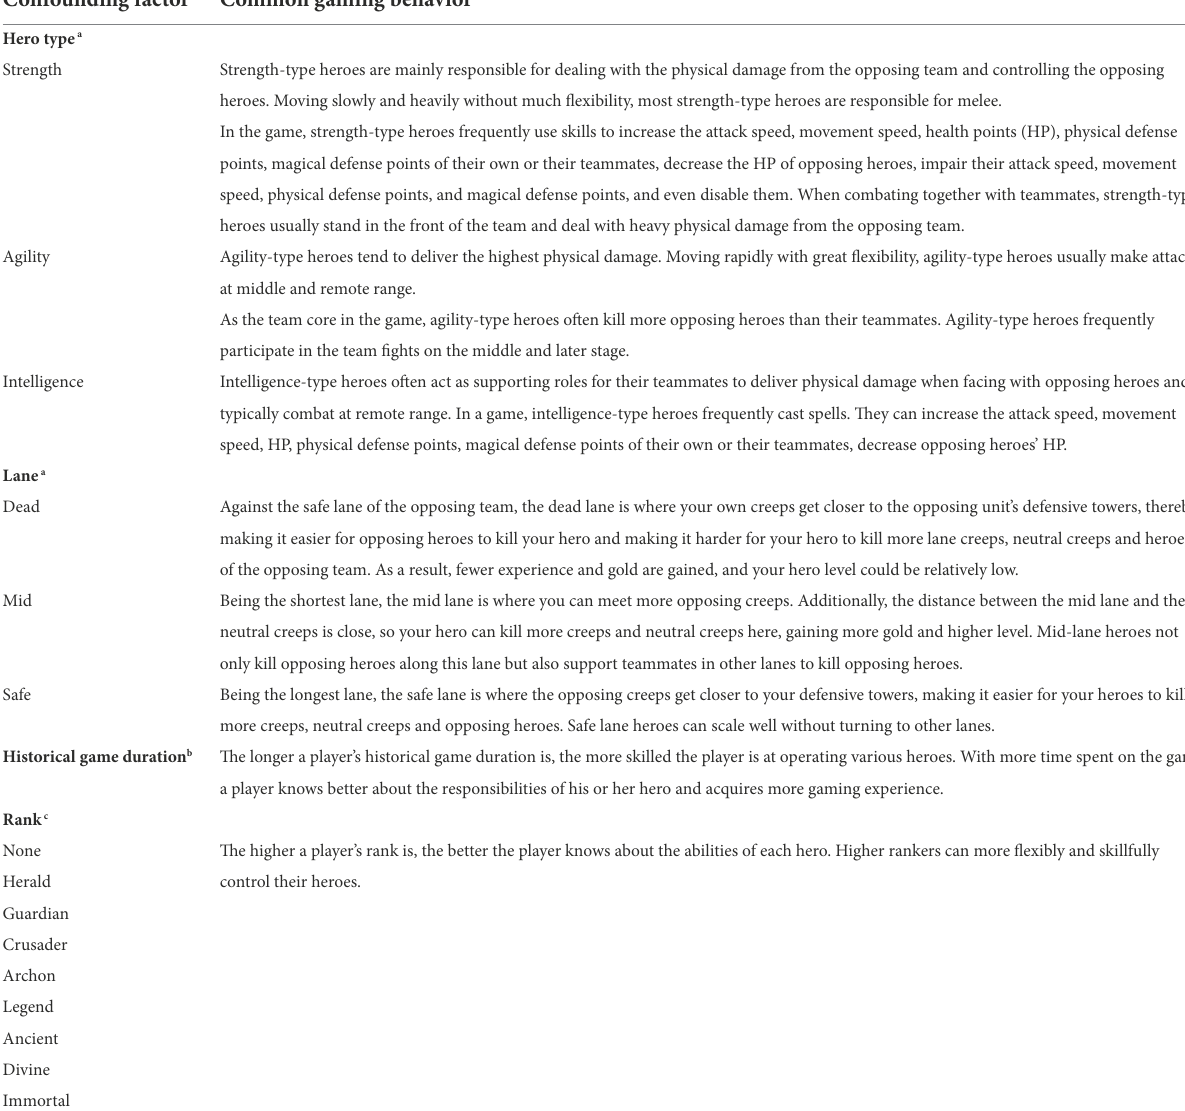
6. Total number of team fights on the middle stage: the total number of times the player has participated in a team fight within 10–30 min after the game starts. 7. Proportion of the number of skills used for teammates: the ratio of the number of times the player uses skills for the hero controlled by his or her teammates to the number of times the player uses skills for all heroes. These seven behavior indicators are affiliated to the three categories of teamwork behaviors based on the aforementioned classifications (as in Table 1): behavior indicators (1)–(3) belong to the task performance, (4) and (5) to the job dedication, and (6) and (7) to the backing up behavior.